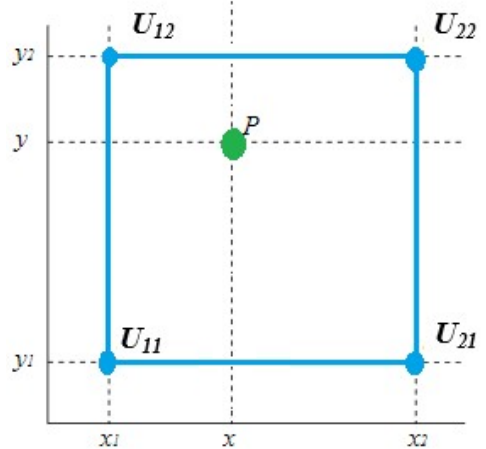
Figure 2. The four blue dots represent the data points, while the green dot represents the interpolation